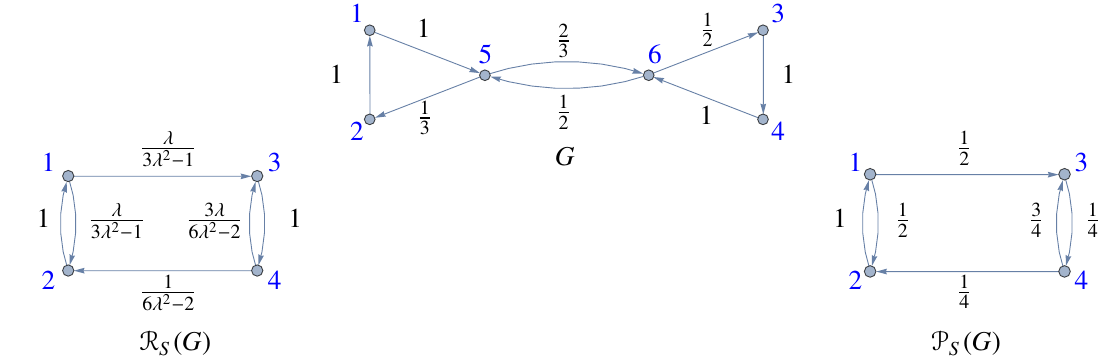
Fig. 1 The network G consisting of six individuals is shown (above) where edge weights indicate the chance that information is passed from one member of the network to one of its neighbors. The reduced network R S ( G ) in which S are the four members { 1 , 2 , 3 , 4 } is shown (left). By setting λ = ρ ( G ) = 1 in R S ( G ) the result is the isoradial reduction P S ( G ) shown (right). The edges in this reduction represent the probability that information is eventually passed from one member of S to another in the original unreduced network G